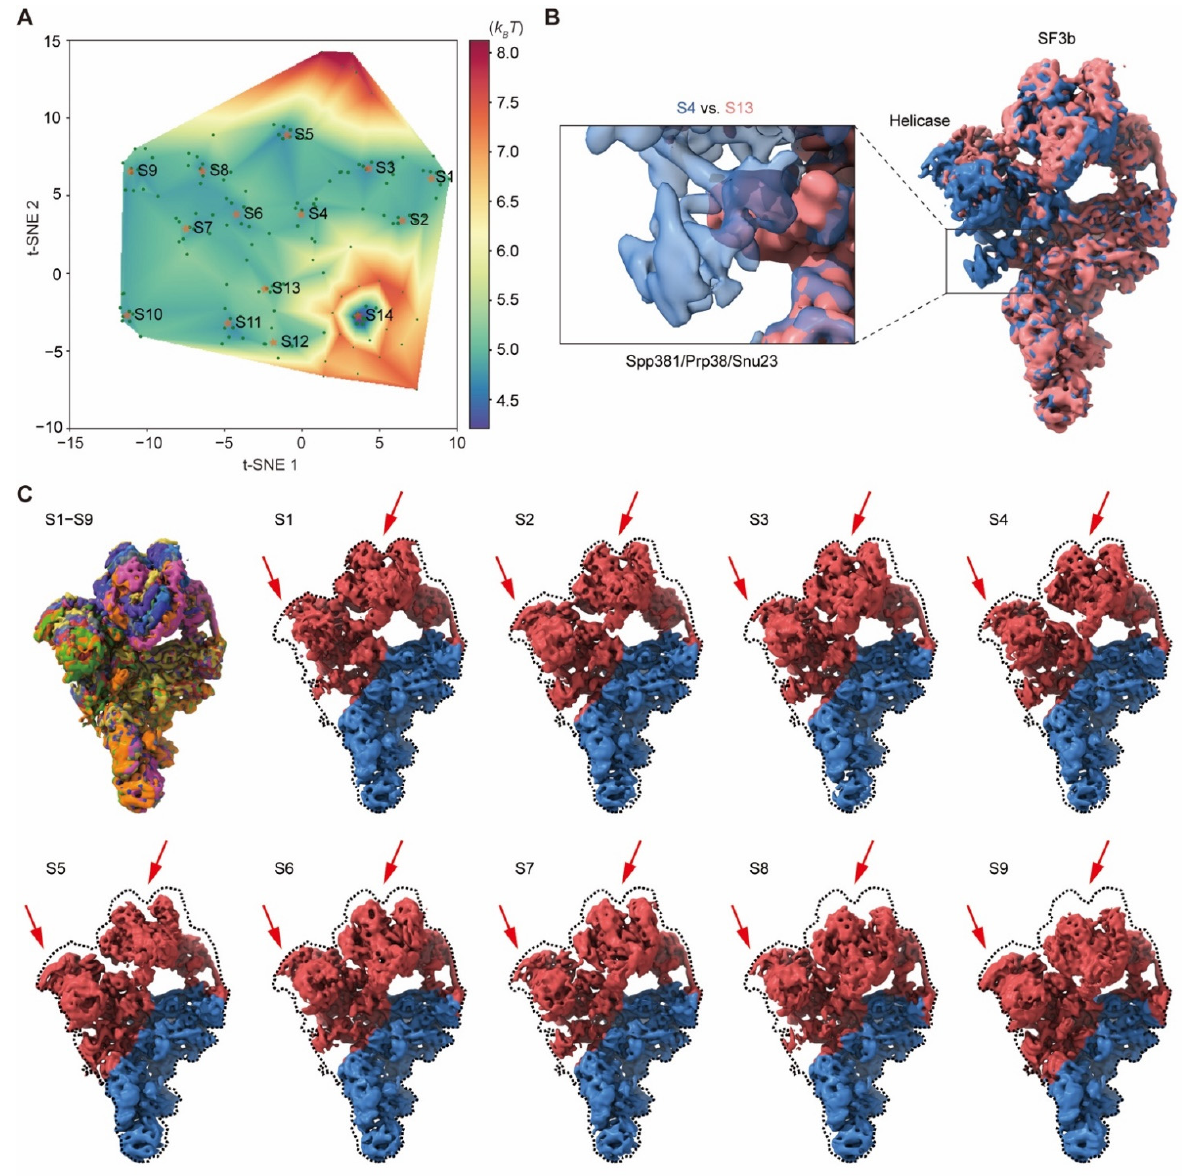
Figure 8. Choreographing continuous inter-subunit motions of the yeast pre-catalytic spliceosome by AlphaCryo4D. ( A ) Pseudo-energy landscape by AlphaCryo4D uncovering 14 clusters designated as S1–S14. Clusters S1–S9 are related to the continuous rotational motion of the SF3b and helicase subcomplexes of the pre-catalytic spliceosome, and the density maps of clusters S10–S14 are shown in Supplementary Figure S6B. ( B ) The density map of the Spp381/Prp38/Snu23-missing state S13 is superimposed with the density map of the state S4. The left inset shows a closeup comparison of the density difference between states S13 and S4 around the subcomplex of Spp381/Prp38/Snu23. ( C ) Cryo-EM density maps of clusters S1–S9. The top leftmost panel shows the superposition of all nine density maps of S1 to S9. In the rest panels, the dynamic component of the density map is colored red and the static component is colored blue. The red arrows highlight the rotational and translational motions of the SF3b and helicase subcomplexes within the dashed outline. The approximate continuous motion of the SF3b and helicase is illustrated in Supplementary Video S3.